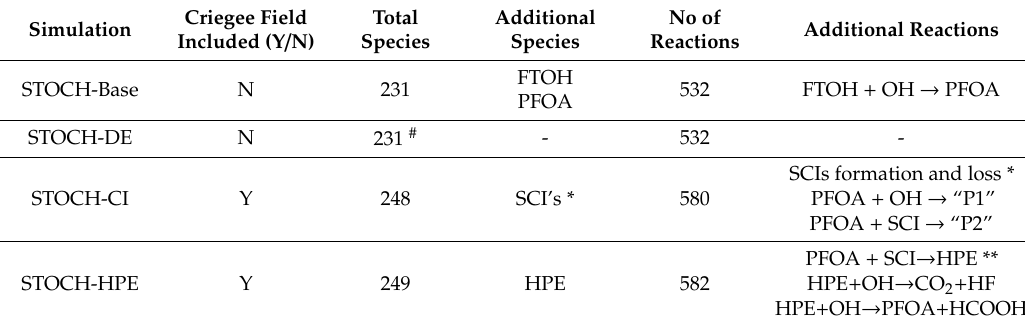
Table 1. Details of each